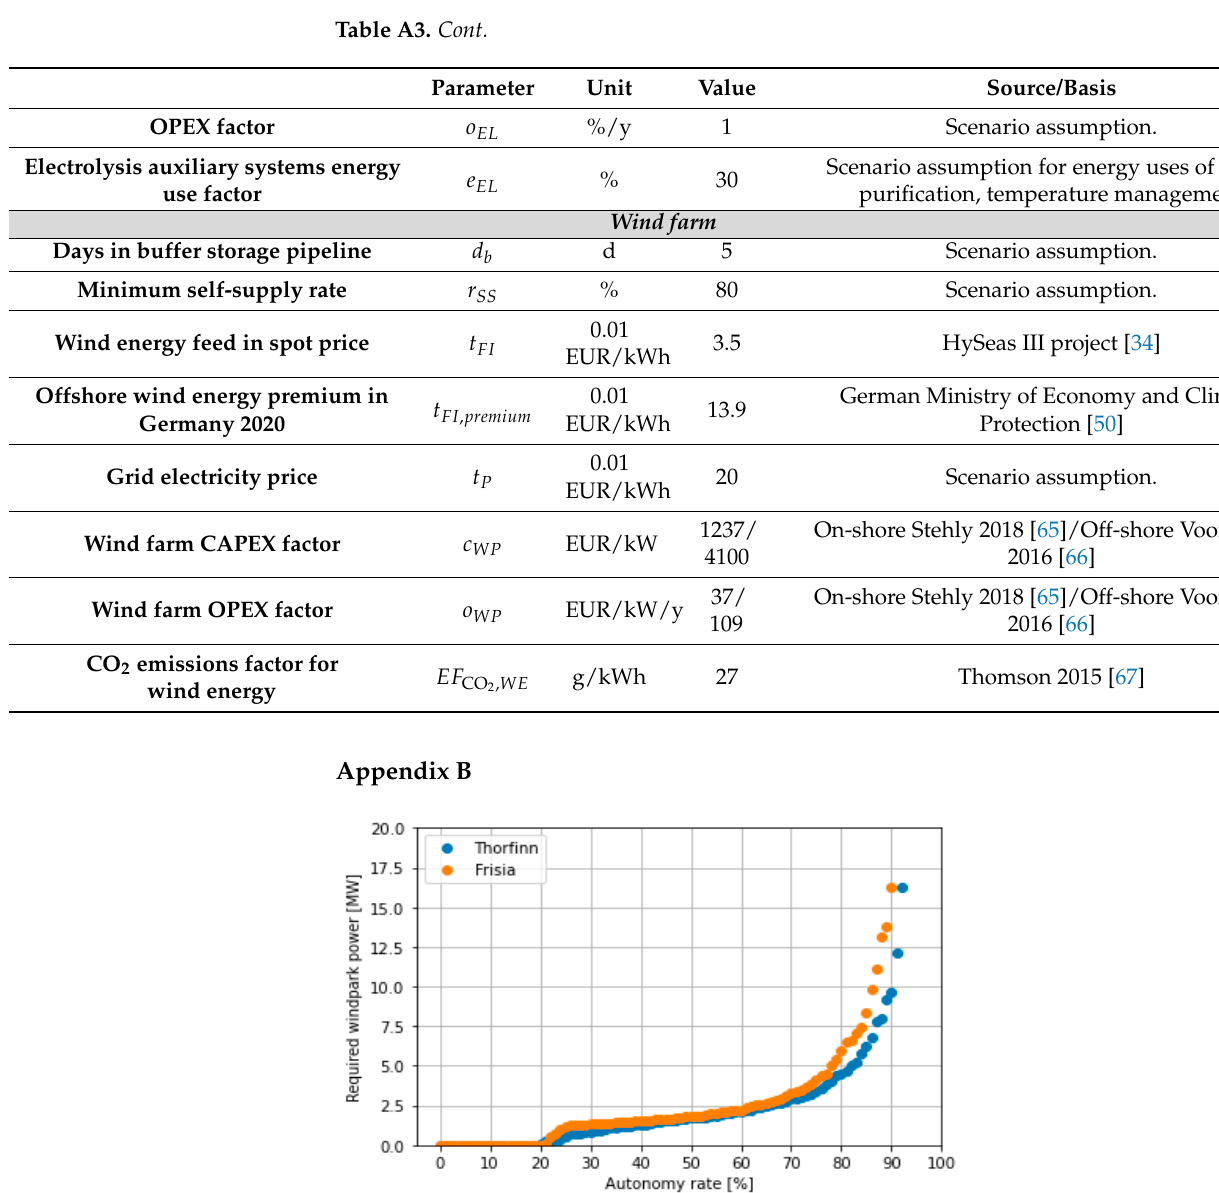
Figure A1. Required wind farm size at different rates of fuel system autonomy, meaning the proportion of days the system is able to generate enough energy for fuel production.